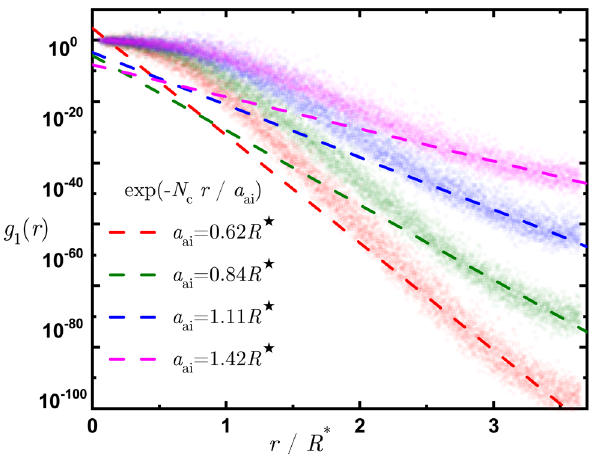
Fig. 5 Residue function of the ion impurity. The symbols show the extrapolated values of the residue g 1 ( r ); the lines show the analytical approximation in terms of a decaying exponent, Eq. (7). Different values of the atom-ion s -wave scattering length a ai are obtained by fi xing b = 0.0023 R ⋆ and by changing c in the ion – atom interaction potential. Simulation is done for N = 50 atoms. Extrapolation procedure based on combining variational and diffusion Monte Carlo data is used to minimize bias on the choice of the trial wave